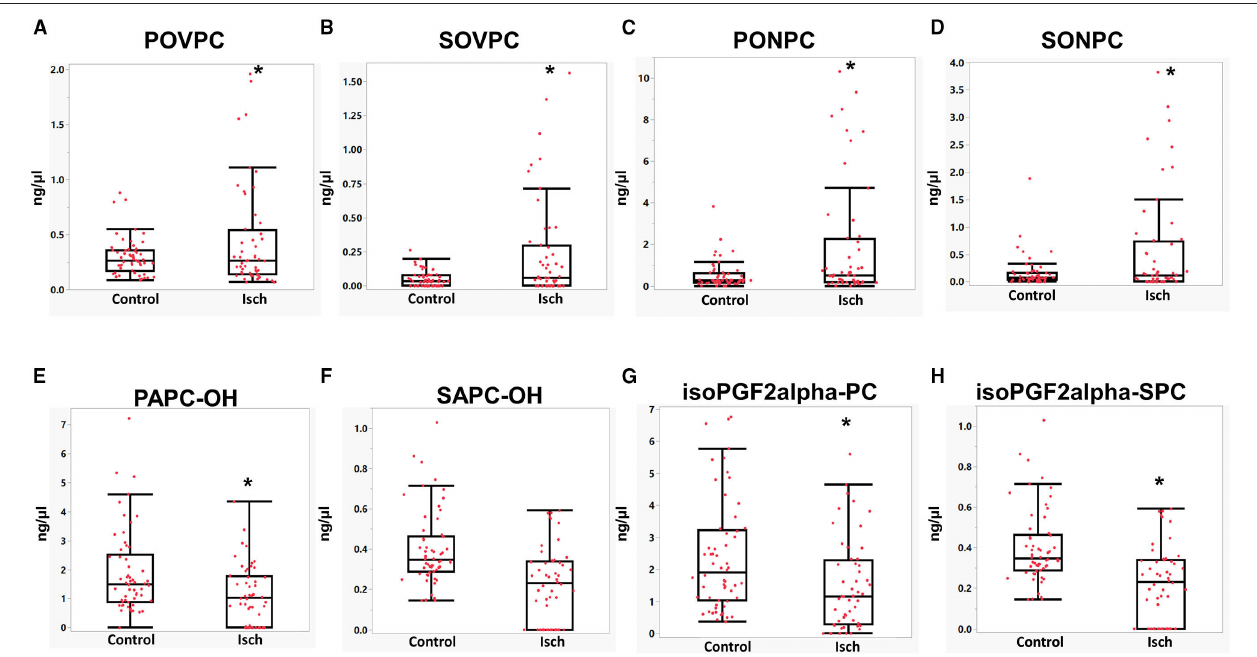
FIGURE 4 | (A–H) Mean comparisons of OxPC species in STEMI patient during ischemia and controls. *Significant differences compared with controls, P < 0.05.